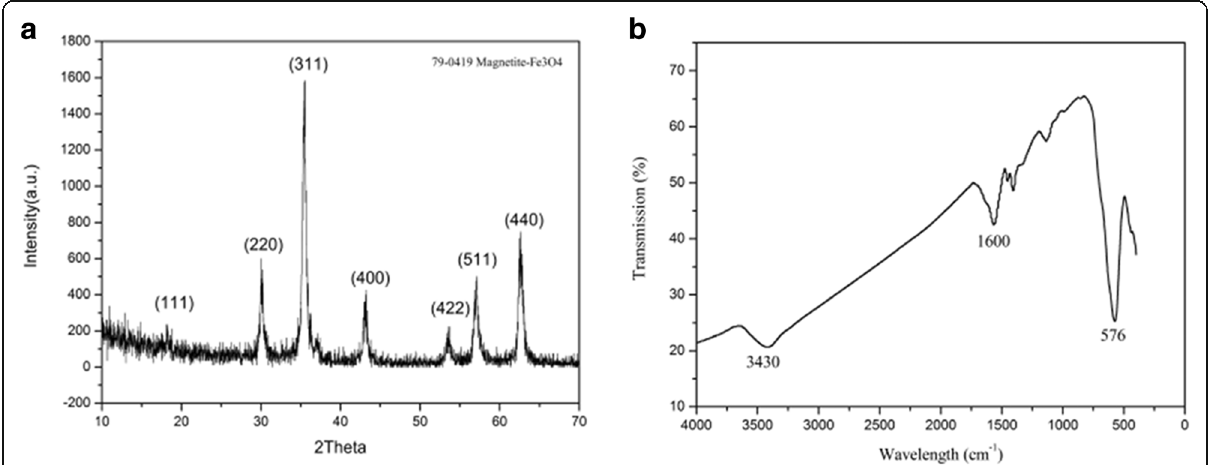
Fig. 1 a XRD pattern of the typical sample. b FT-IR spectrum of the typical